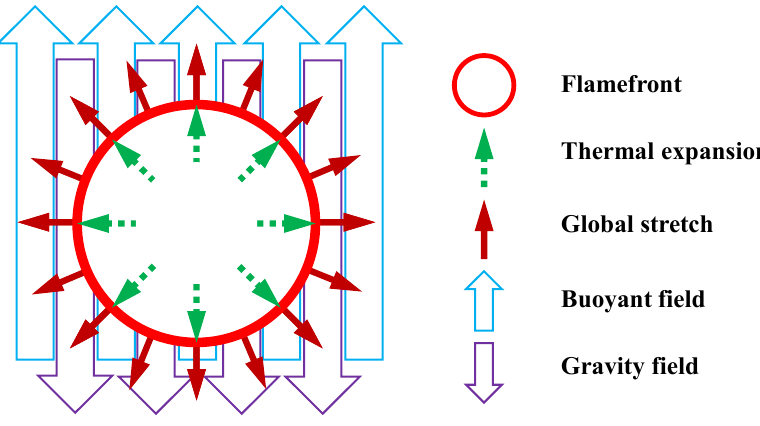
Flamefront Thermal expansion Global stretch Buoyant field Gravity field